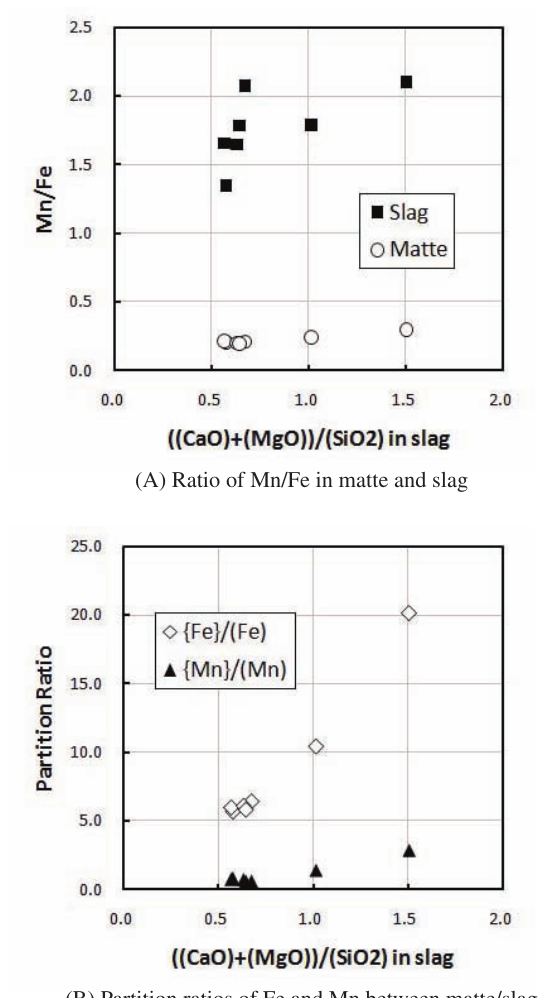
Figure 9. Relationship between (CaO C MgO) = SiO 2 and the composition of matte and slag, as shown in Table 3, (CO/CO 2 ) and P S (SO/SO 2 ) are 10 (cid:3) 12 – 10 (cid:3) 13 where P O 2 2 and 10 (cid:3) 5 – 10 (cid:3) 7 .